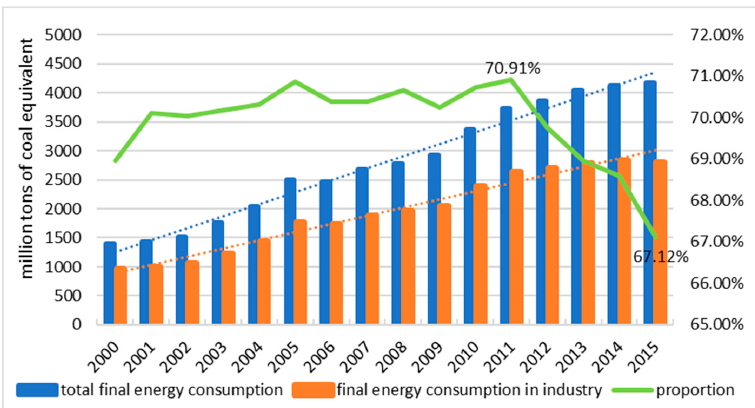
Figure 1. Historical final energy consumption. Final energy consumption in industry has been going up as the total final energy consumption increased in the past fifteen years, and the proportion has decreased sharply in the 12th year plan. Source: State Statistics Bureau—China Statistical Year Book (2000–2016) [31].